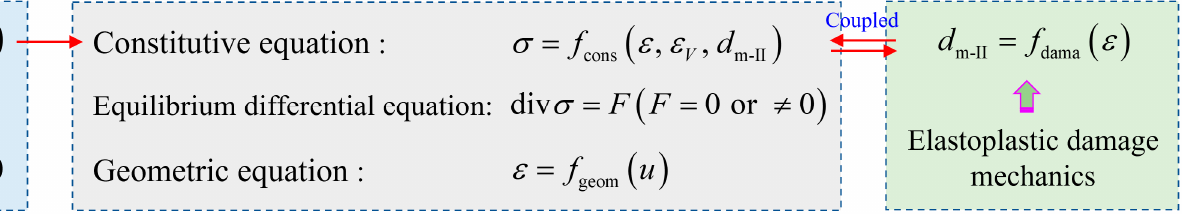
Figure 5. Expressions of damage degree in concrete caused by CSA. Note: f cons , f geom , and f dama are the functions of stress–strain relationship, strain–displacement relationship, and damage degree. F is an external load; u is the displacement.